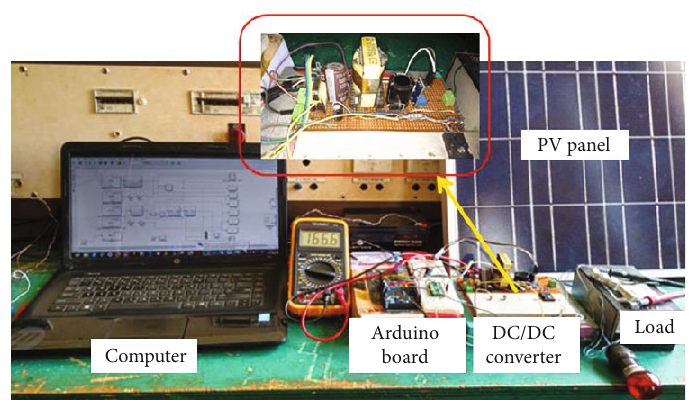
Figure 17: Test bench for experimental validation of the proposed algorithm.